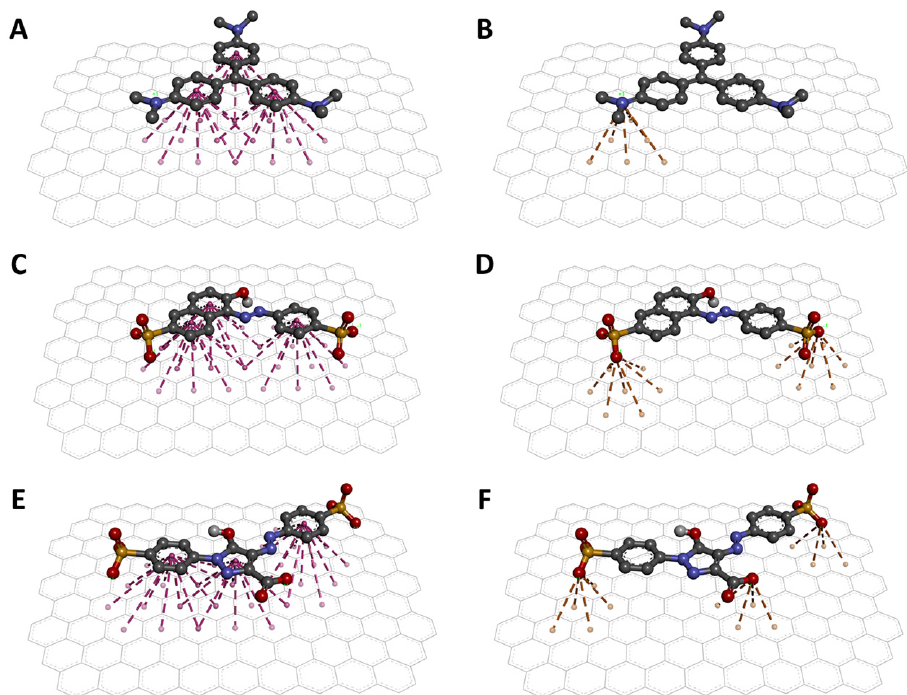
Figure 5. Interaction models of the dyes on the AC surface. π -stacking ( A ) and cation- π ( B ) interactions between CV and AC. π -stacking ( C ) and anion- π ( D ) interactions between SSY and AC. π -stacking ( E ) and anion- π ( F ) interactions between TAR and AC.